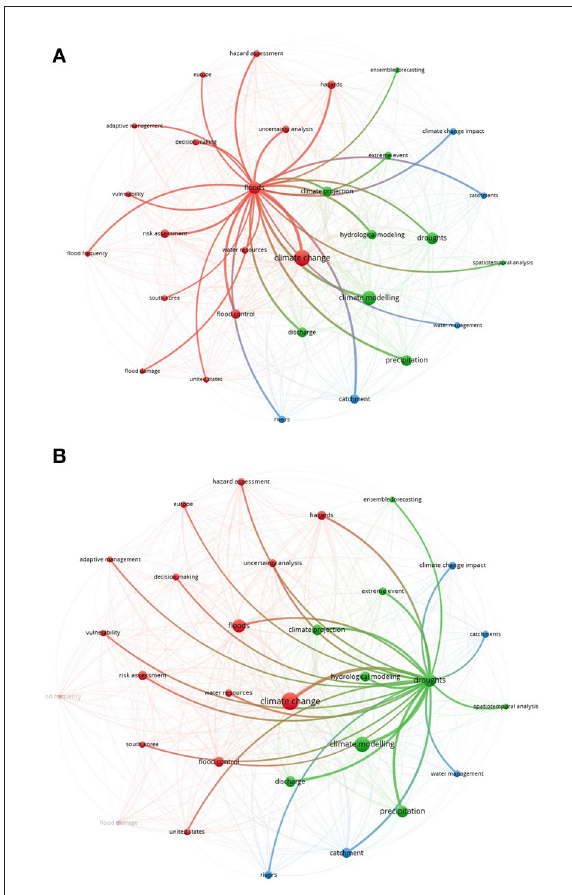
FIGURE4 Analysis of the relationships between key terms (A) for floods and (B) for droughts.